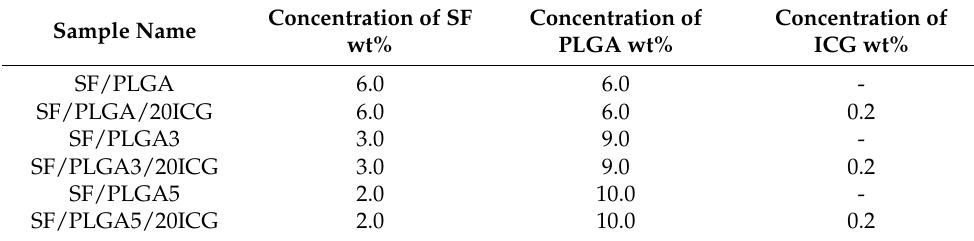
Table 1. Parameters of the nanofibrous membranes.